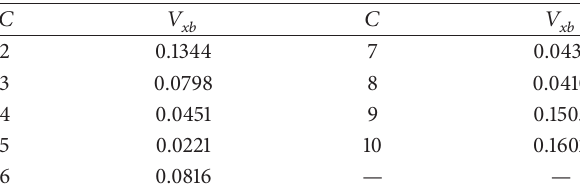
Table 1: The result of cluster.